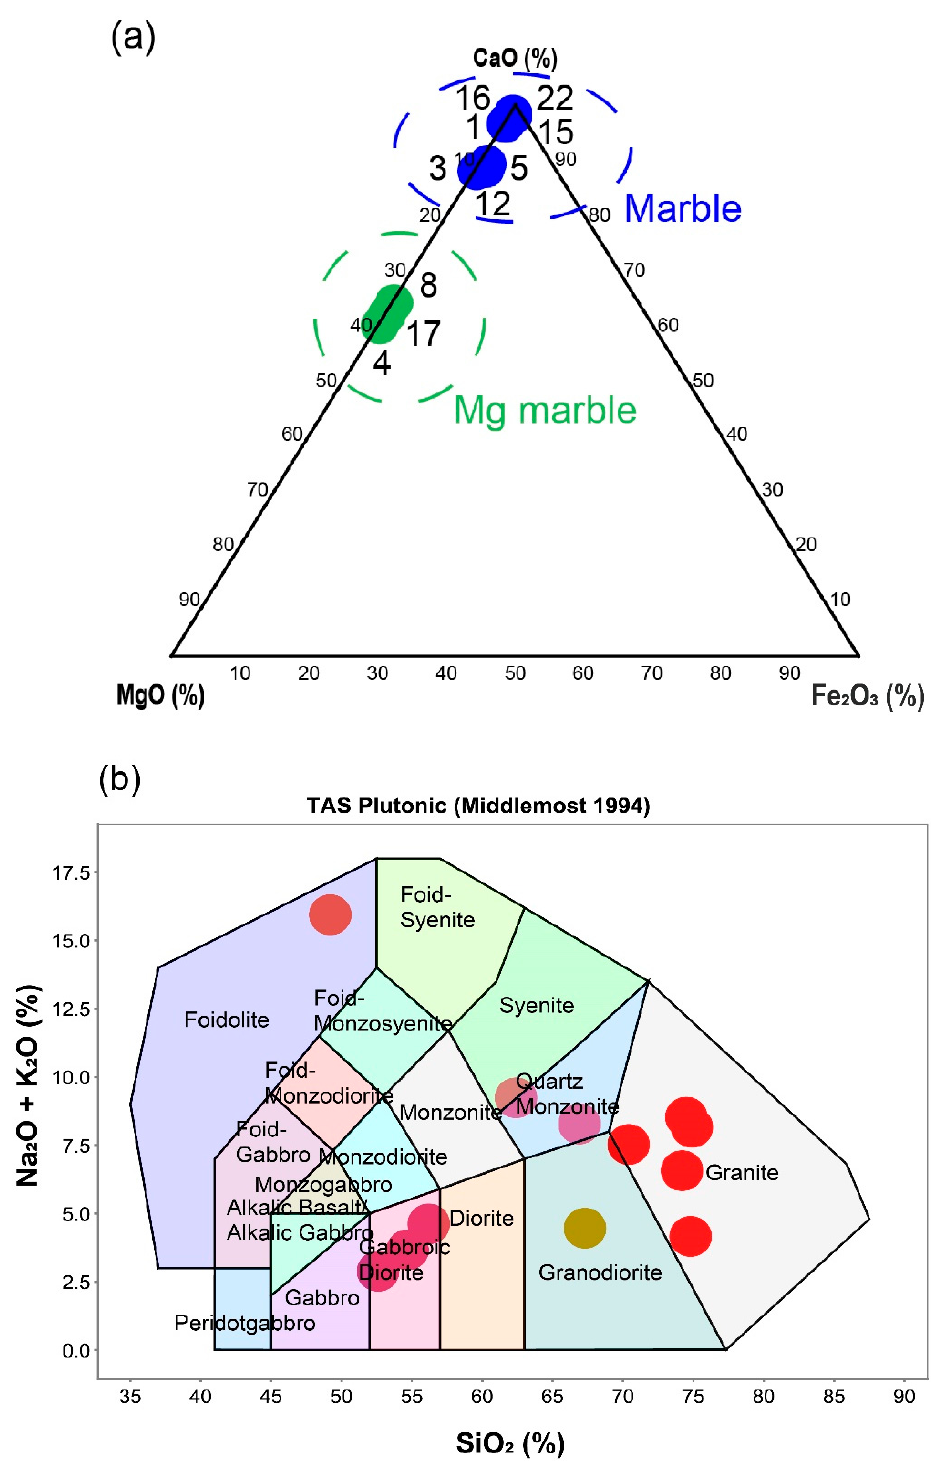
Figure 4. Lithological classification of marble and plutonic slabs based on laboratory whole rock geochemical data. ( a ) CaO-MgO-Fe 2 O 3 ternary diagram used to classify marble slabs. ( b ) Total alkali versus silica diagram (TAS) [32] used to classify the plutonic rocks. Numbers shown next to sample points correspond to the rock slab number shown in Figure 2a. Sample colours legend is shown in Figure 2c.